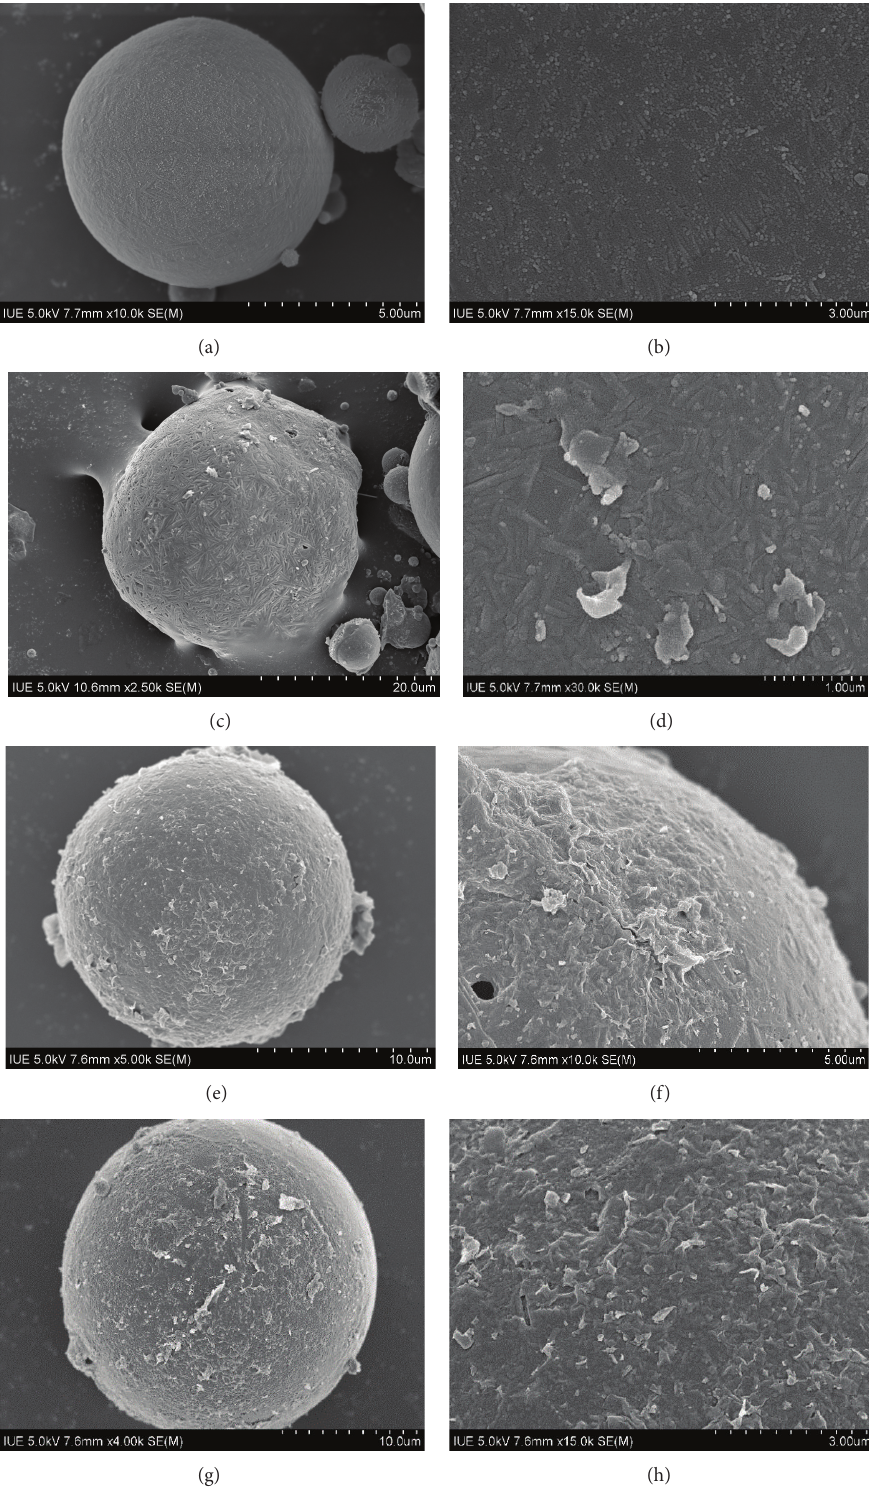
Figure 1: The SEM images of samples as-prepared: (a) and (b) CFA; (c) and (d) Ti 0.91 O 2 /CFA-2; (e) and (f) Ti 0.91 O 2 /CFA-4; (g) and (h) Ti 0.91 O 2